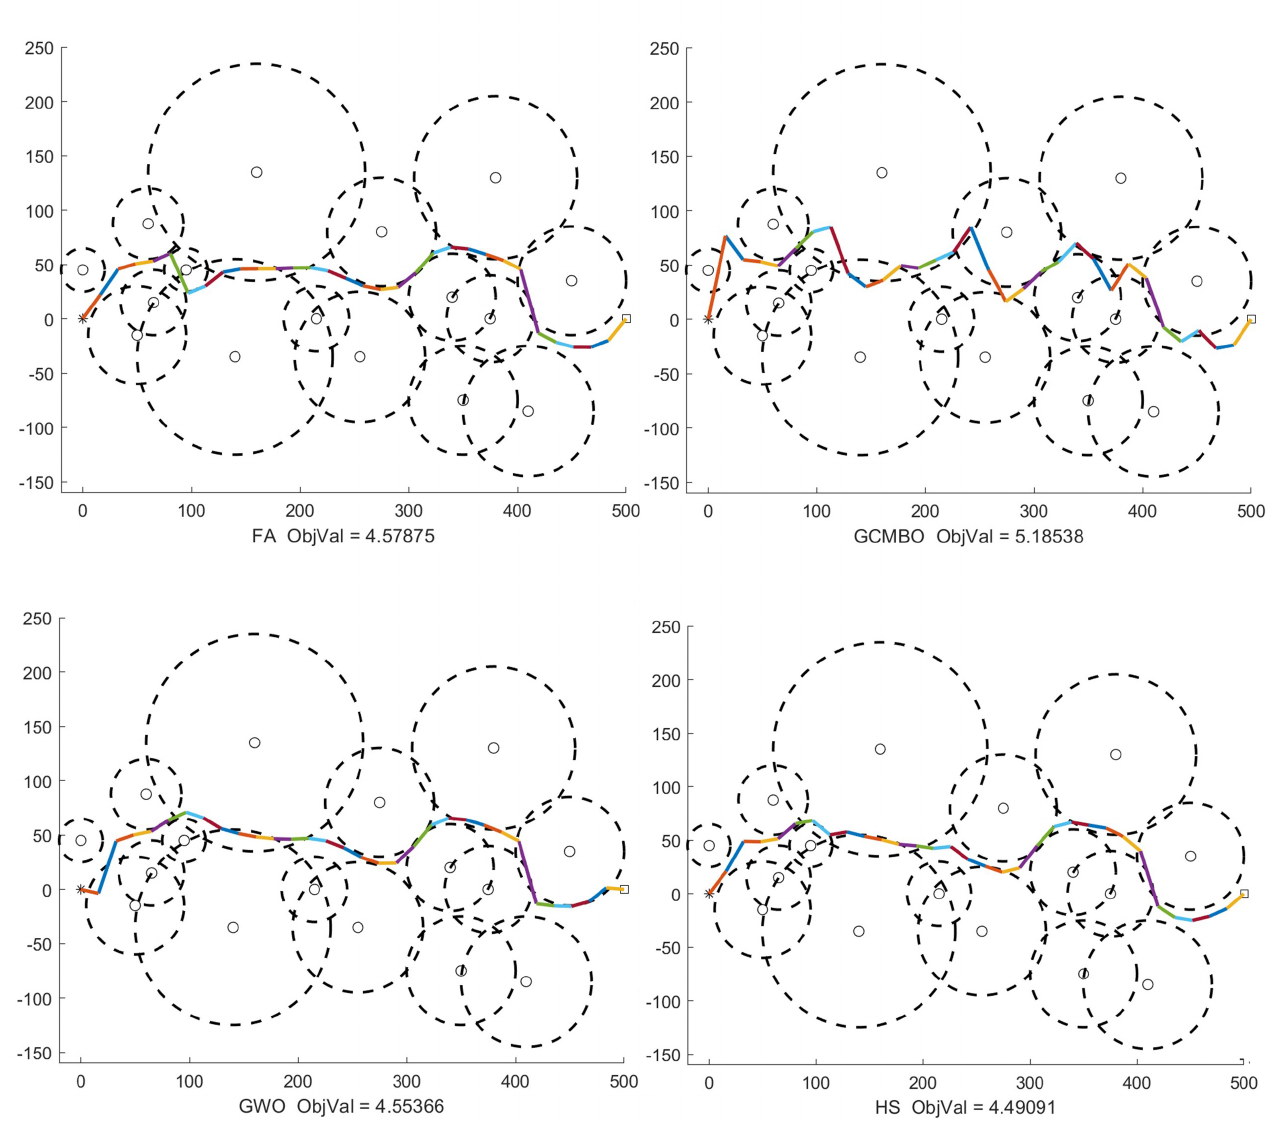
Figure 7. The comparison performance of different swarm intelligence algorithms including FA, GCMBO, GWO and HS for Case 8 with D = 30, N =